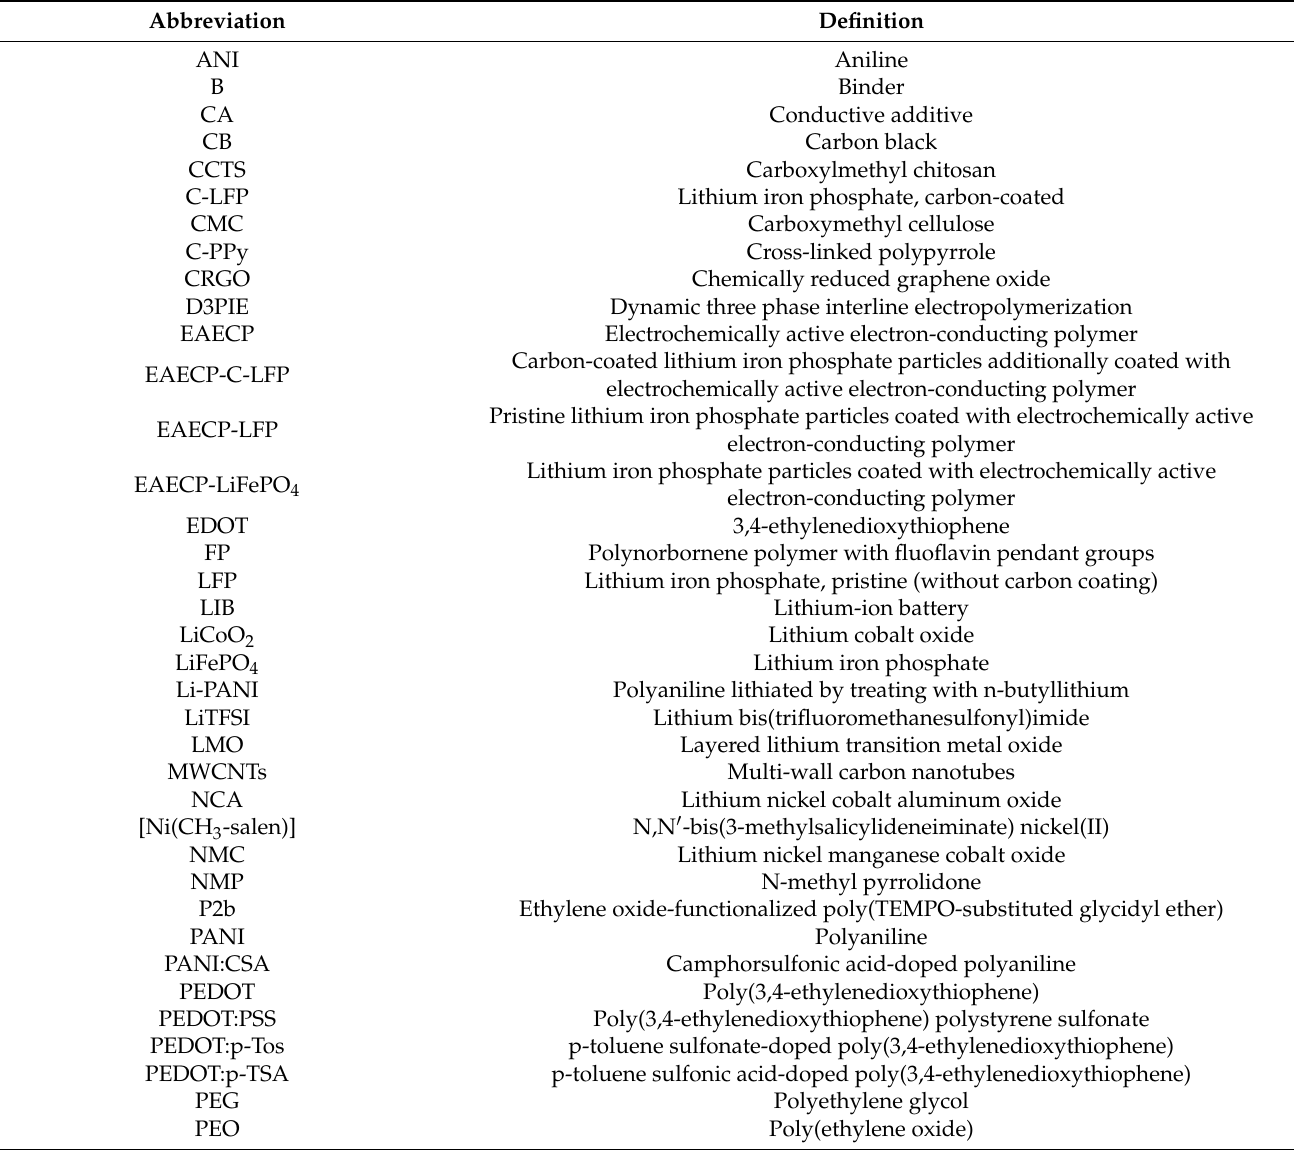
Table 1. Acronyms and